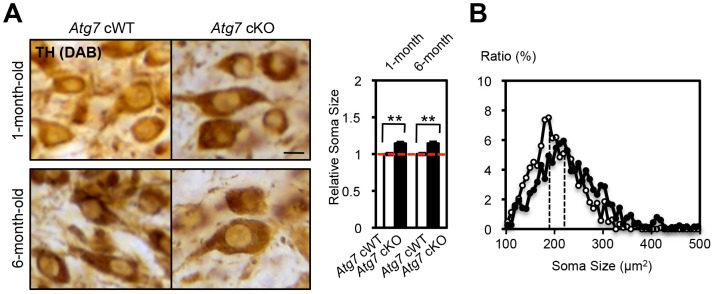
Enlarged soma size in TH-positive DA neurons of Atg7 cKO mice.(A) Enlarged cell soma of TH-positive DA neurons in Atg7 cKO mice. The soma area (brown in pictures) of nigral TH-positive DA neurons in Atg7 cKO mice (black in graph) was approximately 15% larger than that in Atg7 cWT mice (white in graph), as quantified using Image-J software (Image J, Bethesda, MD) and presented relative to the area of the Atg7 cWT group. Bars, 10 µm. (Atg7 cWT mice = 1.0); n = 194 to 377 TH-positive DA neurons per group. **, p<0.01. (B) The distribution of cell soma size of TH-positive DA neurons in Atg7 cWT and Atg7 cKO mice. The soma size of TH-positive DA neurons in Atg7 cKO mice (black circle) was on average approximately 15% larger than that in Atg7 cWT mice (white circle).